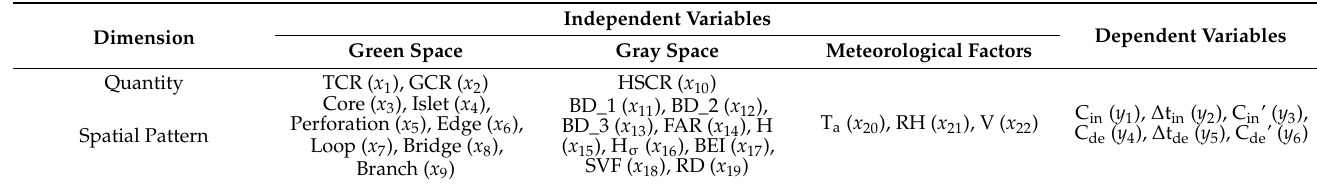
Table 1. Indicators for model